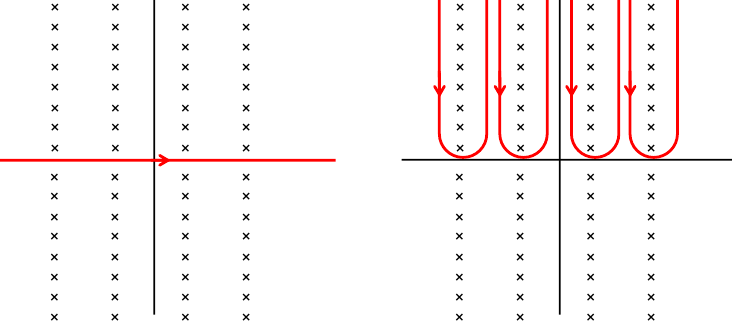
The cosh (cid:25)w (cid:1) ( x; m ) factors which do not contribute to the pole, together with the A Vandermonde factors, give the functions f H the functions f C ( (cid:16) v